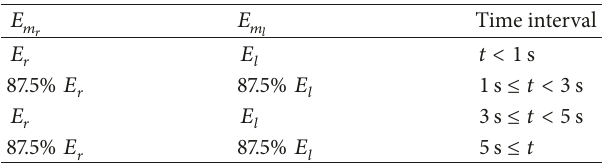
Table 5: Abrupt changes in 𝐸 𝑟 and 𝐸 𝑙